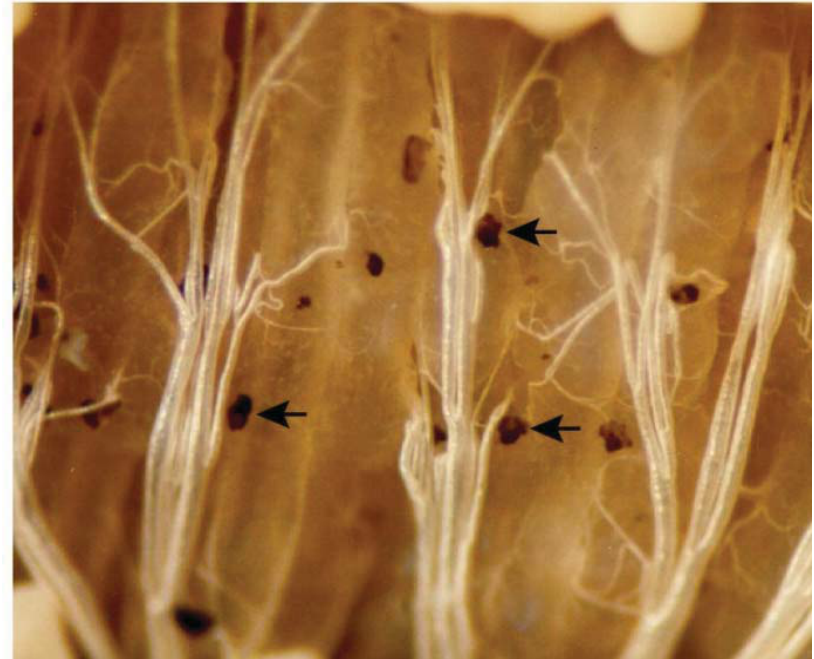
Figure 2. Nodules formed 4 h following an artificial infection by injecting the bacterium Serratia marcescens , into the hemocoel of a tobacco hornworm. The arrows point to melanotic nodules (approximately 0.1 mm in diameter) against the background of the highly tracheated